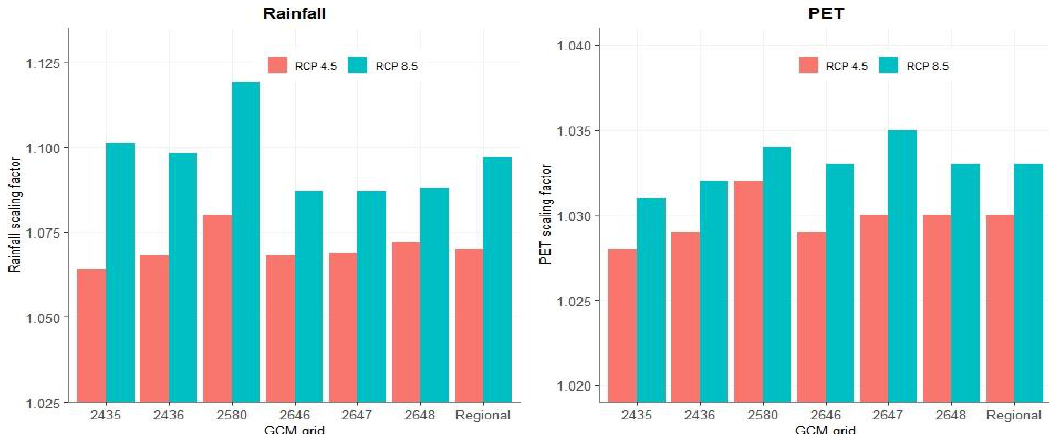
Figure 8. Spatial variations of annual rainfall and PET between six GCM grids in the northwest region of Bangladesh for the RCP 4.5 (red bars) and RCP8.5 (light blue bars) emission scenarios.